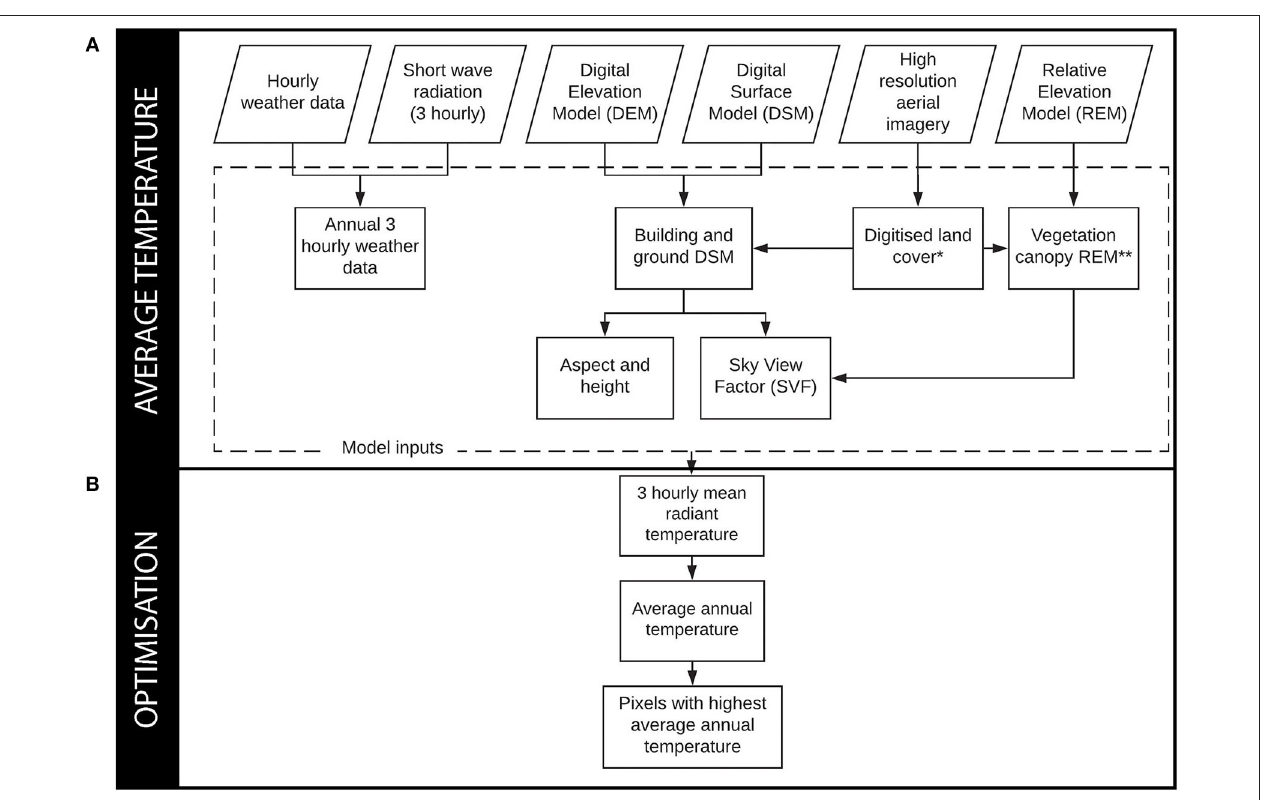
FIGURE 1 | Summary of methodological procedures for (A) mean radiant temperature ( T mrt ) and (B) identifying optimal tree locations. *indicates existing development modified using proposed redevelopment plans. **indicates data were modified on three occasions: (1) using proposed redevelopment plans, (2) removing all trees across the proposed redevelopment site, and (3) using optimal tree